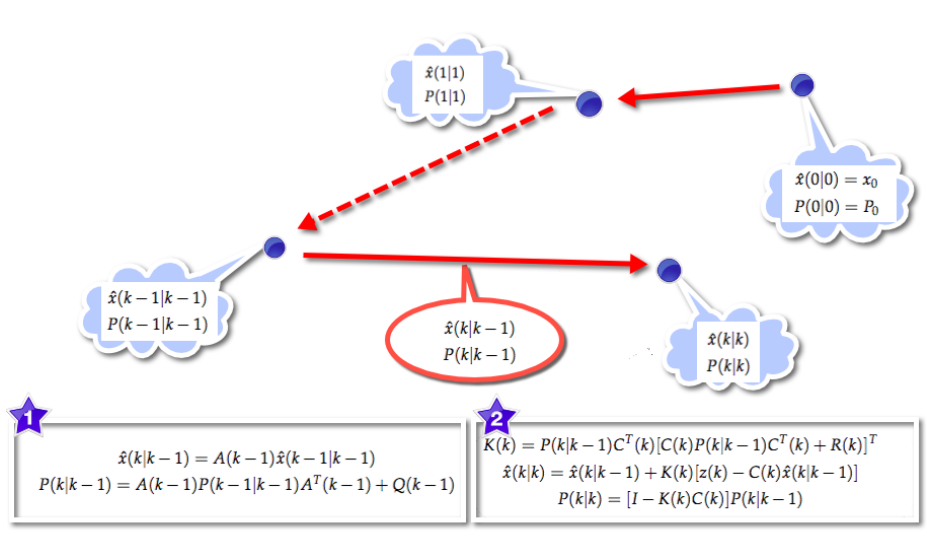
Figure 6. Illustration of Kalman filter. From an initial value ˆ x ( 0 | 0 ) , two steps are used to obtain the final estimate: ( 1 ) Prediction step. The Kalman filter produces prediction estimates ˆ x ( k | k − 1 )